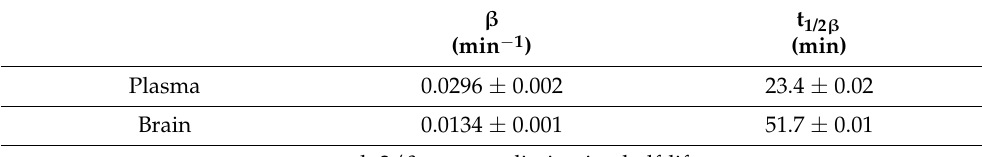
Table 7. Pharmacokinetic parameters obtained by analysis of rat tissues after intravenous injection of 2-PAM in IA-16/PC liposomes (dose 25 mg/kg). Results presented as mean ± standard error for five